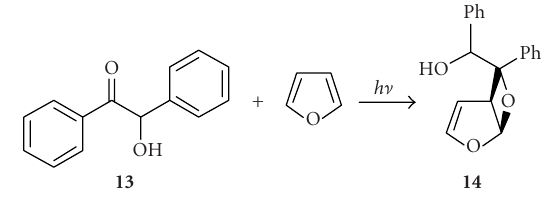
Figure 9: Photochemical reaction between benzoin and furan.